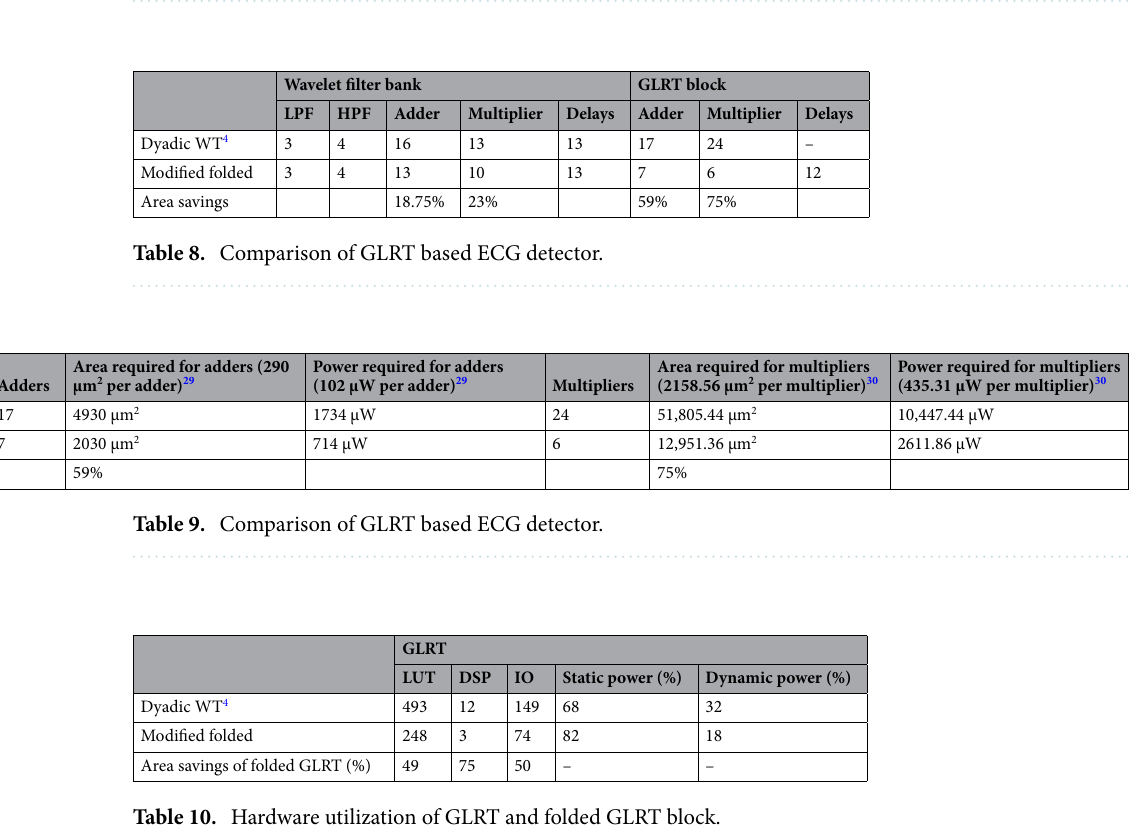
Table 7. Hardware comparison of WFB with existing structures.